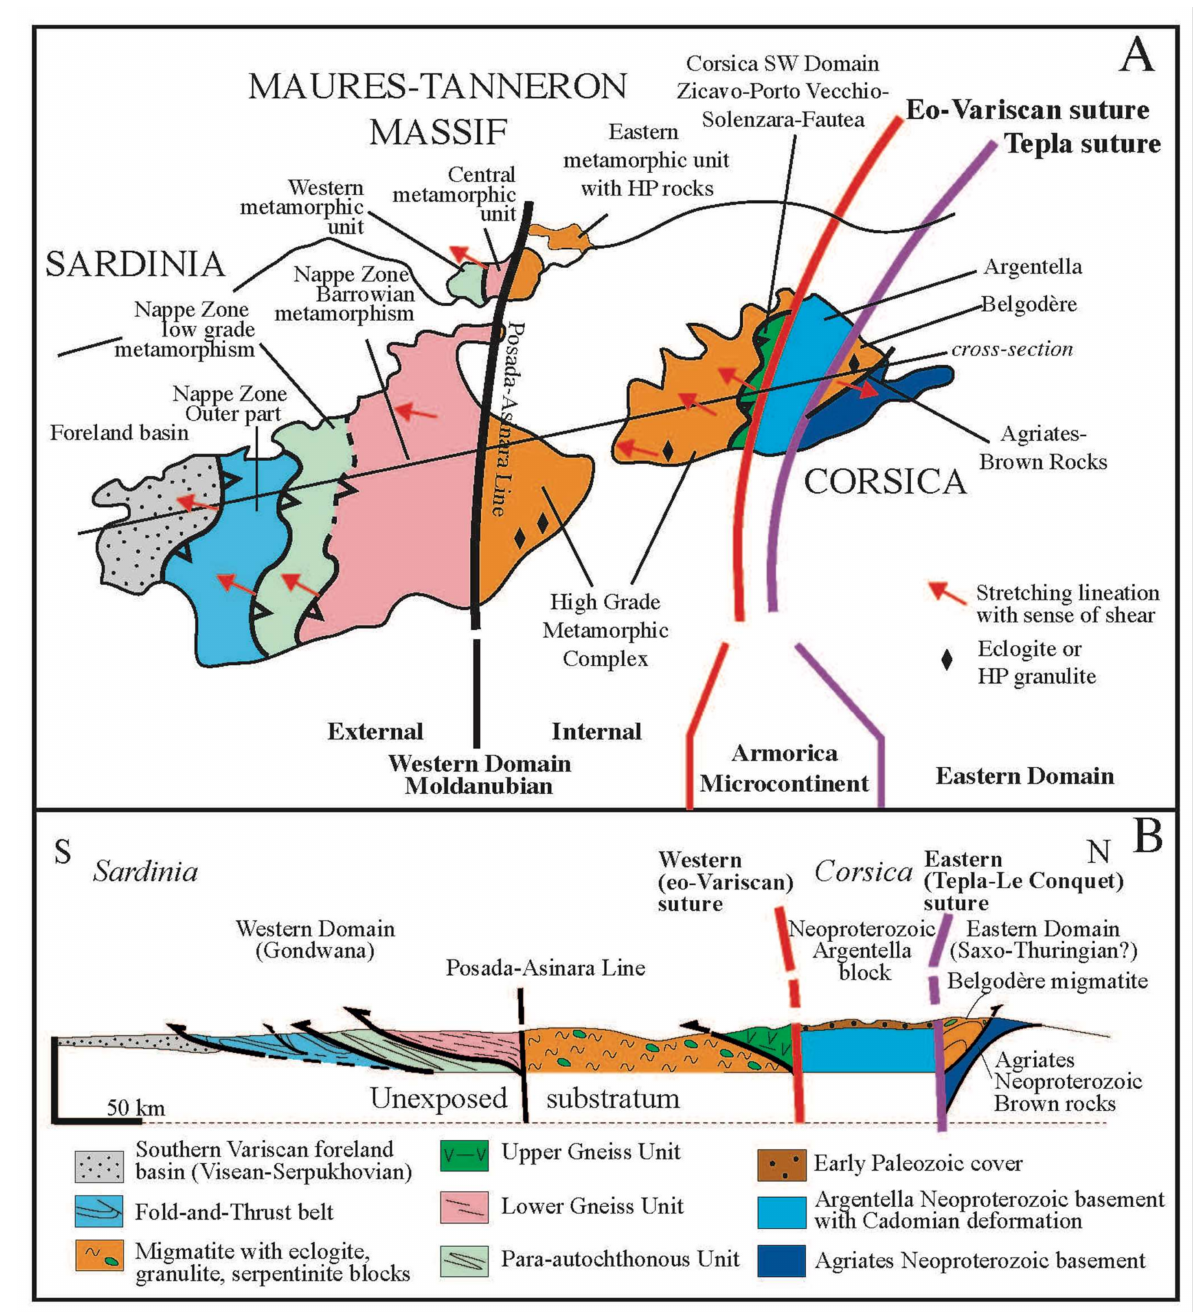
Figure 4. The Sardinia–Corsica segment. ( A ): Tectonic correlation between the Sardinia, Corsica, and Maures massifs restored to their pre-Cenozoic position. The North–South zonation (in the present position), is similar to that recognized in the French Massif Central, and the Maures Massif. In NW Corsica, the Argentella area, characterized by a Neoproterozoic basement and its Paleozoic cover, is correlated with the Armorican Domain. In the Belgod è re and Agriates areas, the top-to- the-east shearing suggests that they belong to the Saxo-Thuringian Domain. The granitic intrusions are not shown. ( B ): schematic cross-section of the nappe stack in the Sardinia–Corsica segment (in its present orientation), and possible correlations with the main units recognized in the French Massif Central. The southern part of the section is similar to the Moldanubian Domain, whereas the northwestern (Argentella), and Central Corsica (Belgod è re–Agriates) parts are correlated with Armorica and Saxo-Thuringian Domains,